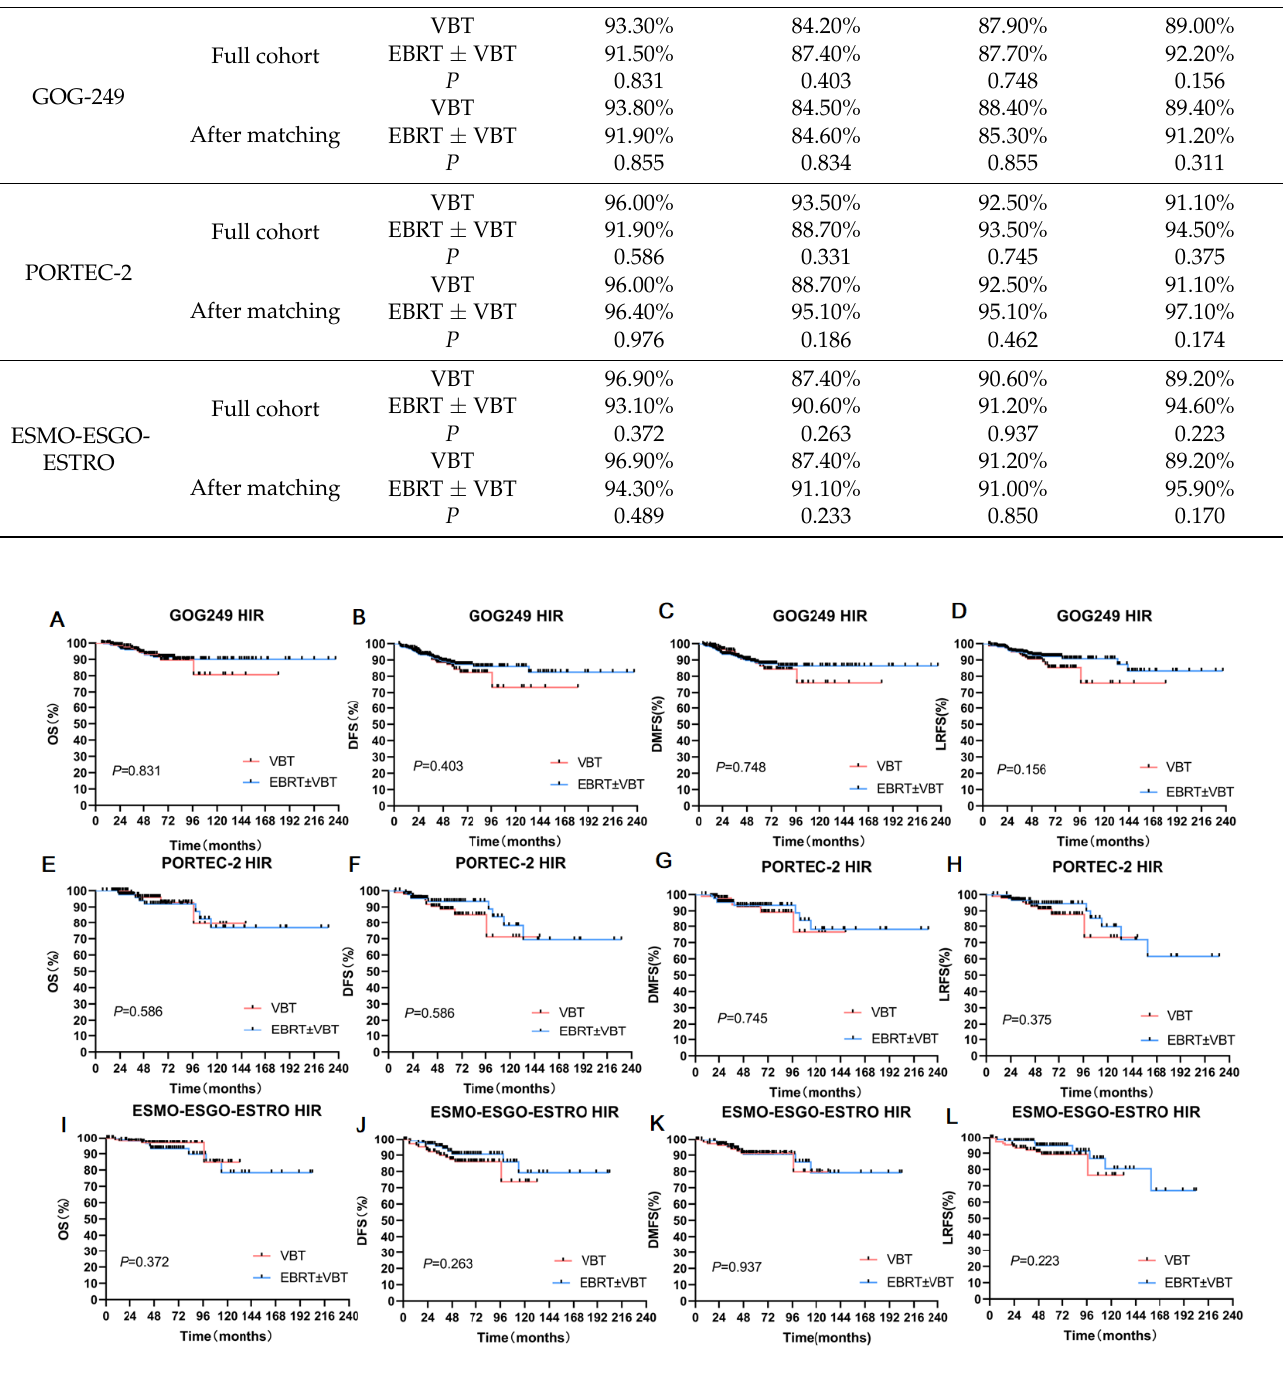
Figure 3. Subgroup analyses of three HIR groups. ( A ) OS for two RT modes in the GOG-249 HIR Group. ( B ) DFS for two RT modes in the GOG -249 HIR group. ( C ) DMFS for two RT modes in the GOG -249 HIR group. ( D ) LRFS for two RT modes in the GOG-249 HIR group. ( E ) OS for two RT modes in the PORTEC -2 HIR group. ( F ) DFS for two RT modes in the PORTEC -2 HIR group. ( G ) DMFS for two RT modes in the PORTEC -2 HIR group. ( H ) LRFS for two RT modes in the PORTEC -2 HIR group. ( I ) OS for two RT modes in the ESMO-ESGO-ESTRO group. ( J ) DFS for two RT modes in the ESGO-ESTRO HIR group. ( K ) DMFS for two RT modes in the ESGO-ESTRO HIR group. ( L ) LRFS for two RT modes in the ESGO-ESTRO HIR